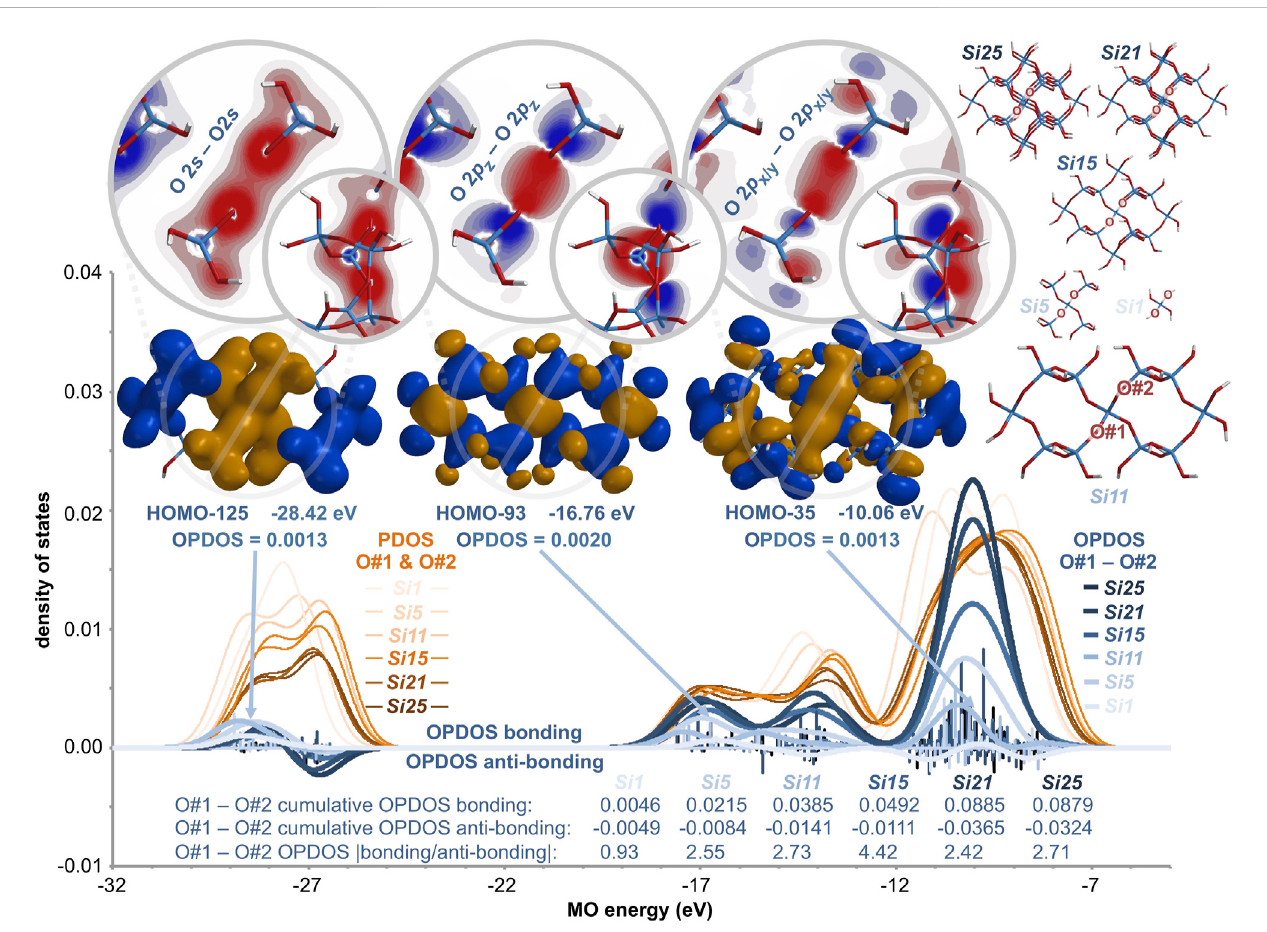
FIGURE 13 Partial (PDOS, orange)and overlap population (OPDOS,blue) density ofstates map for acentral oxygen-oxygen interaction in silica clusters Si1 , Si5 , Si11 , Si15 , Si21 , and Si25 . Conventional bonding models predict minimal O-O bonding or net O-O anti-bonding, as indicated for Si1 (|bonding/anti-bonding| < 1). However, OPDOS computations reveal net bonding (|bonding/anti-bonding| > 1) for a central O-O of Si5 and larger clusters. The computational method is DFT/B3LYP/6-311++G** and representative O#1 – O#2 bonding molecular orbitals (HOMO-125, HOMO-93, and HOMO-35) for the Si11 cluster are depicted with IsoValue = 0.01 [e/bohr 3 ] 0.5 — along with orthogonal cross sectional slices having the same wavefunction scale as that in Figure